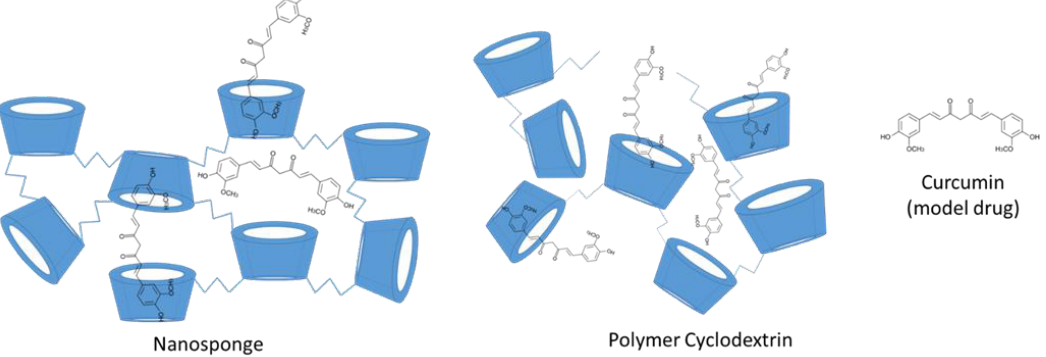
Figure 4. The structure of cyclodextrin nanosponge and polymer cyclodextrin with the model guest molecule curcumin.